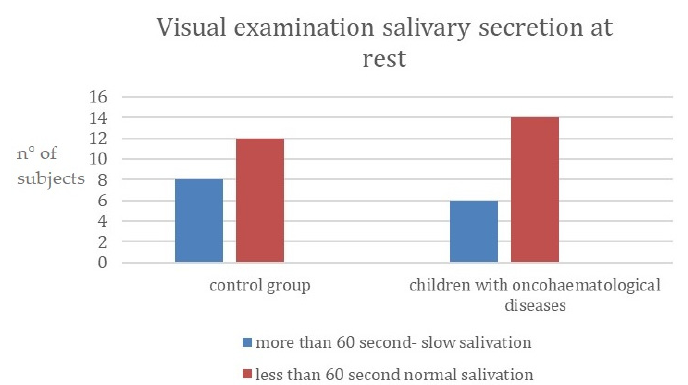
Figure 1. Visual examination of salivary secretion at rest. (Y axis: n° of subjects = number of subjects for each category).